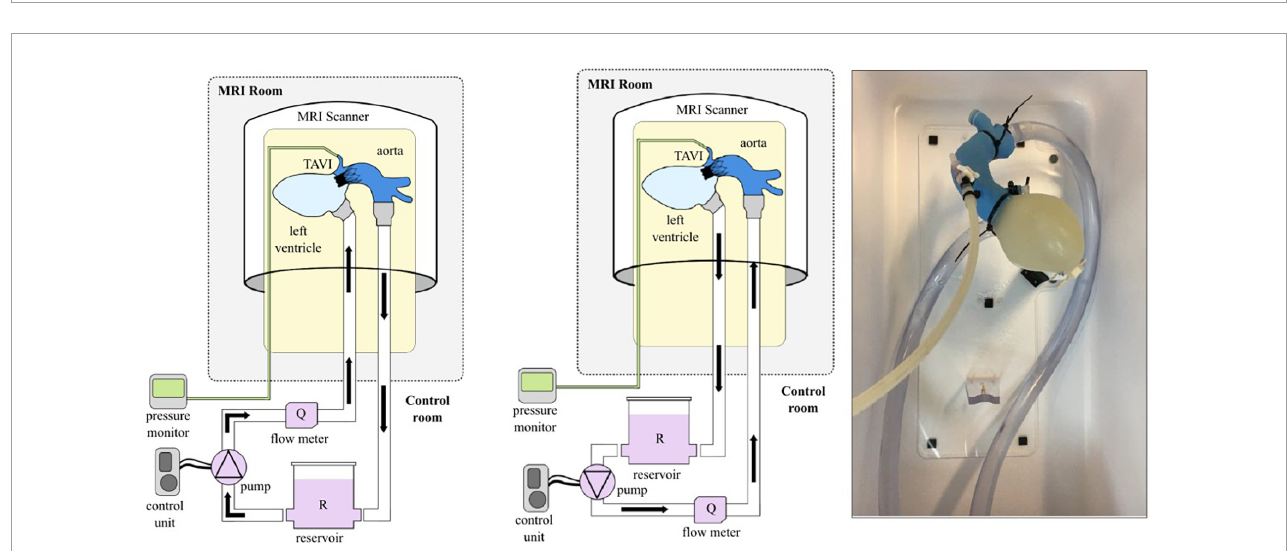
FIGURE2 Schematic representation of the setup in the case of antegrade (left) and retrograde (middle) flow and photograph of the mock loop (right) .